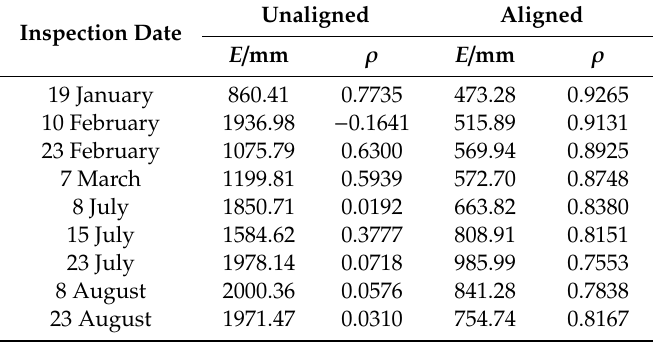
Table 1. Deviation statistics of sequences compared to the reference sequence.